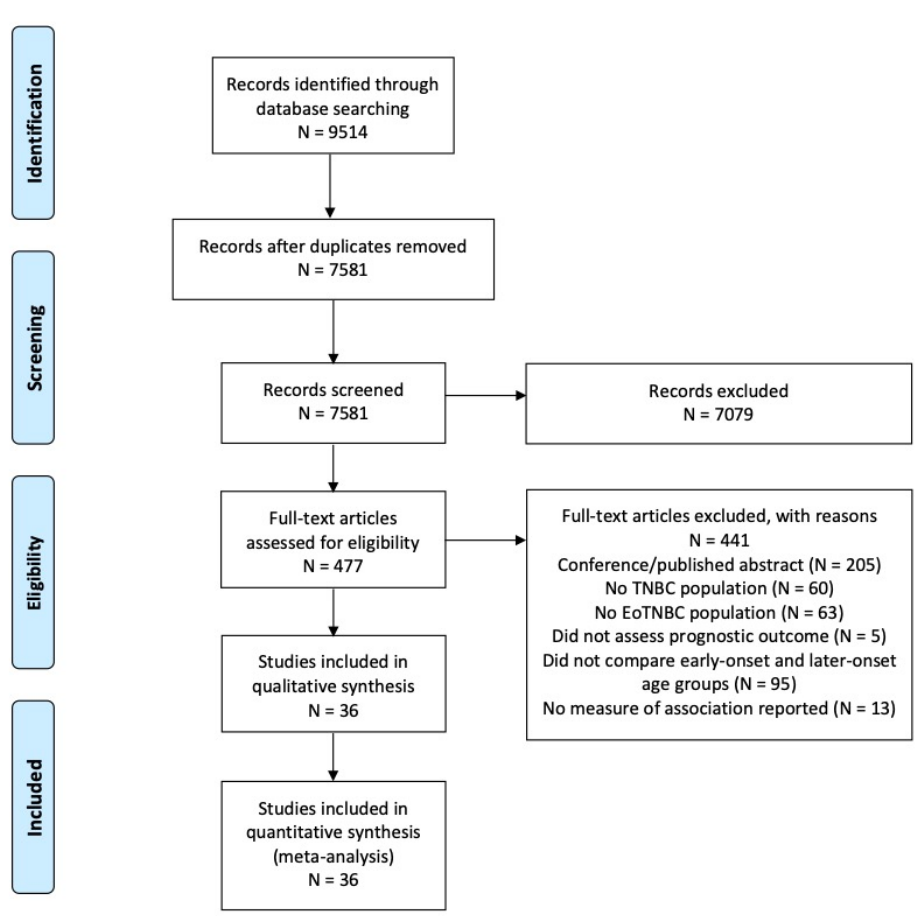
Figure 1. PRISMA flow diagram of included and excluded studies based on eligibility criteria [22].